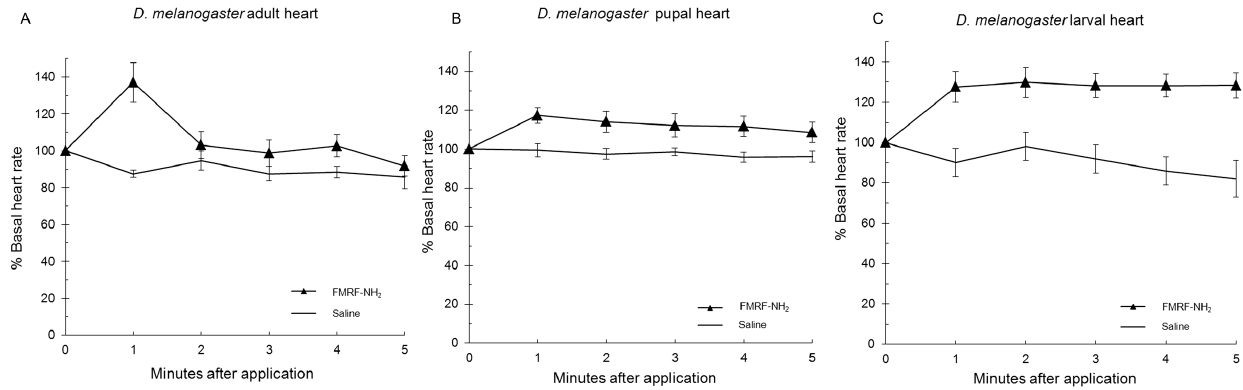
Figure 10. FMRF-NH 2 applied to heart. The effect of the conserved tetrapeptide FMRF-NH 2 on heart rate is reported as mean values 6 S.E.M. The effects are shown in adult (A), pupal (B), and larval (C)